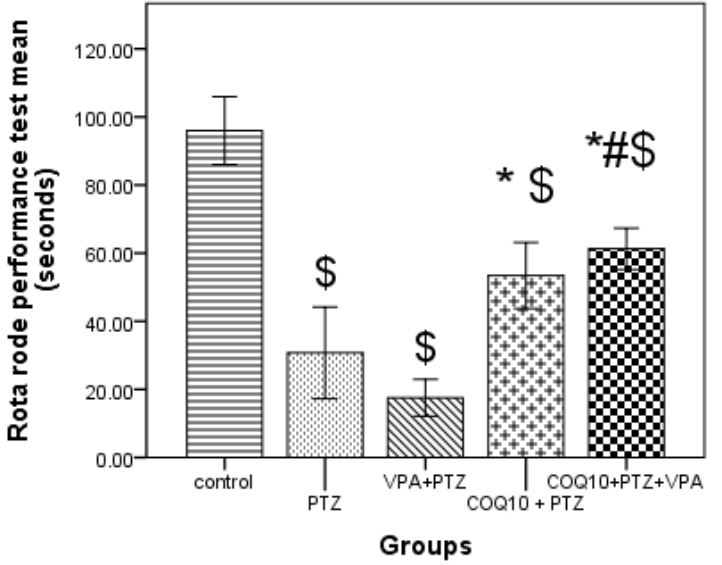
Figure 3. Effects of COQ10 on a Pentylenetetrazole rat’s behavior according to the rota rod performance test. The data are expressed as the mean ± the standard error of the mean ( N = 6), one-way ANOVA, and post hoc Tukey’s test. $ p < 0.05 compared to group I (control); * p < 0.05, compared to PTZ alone group; # p < 0.05 for the PTZ/VPA + COQ10 group compared to group PTZ/VPA.